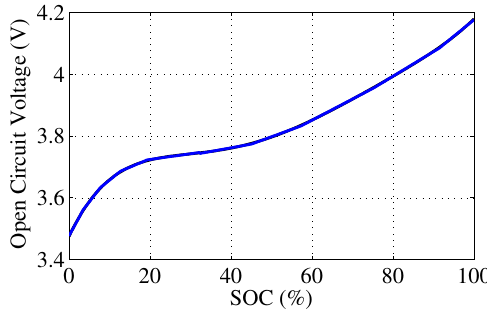
Figure 2. Experimental SOC-OCV relationship of a LIB